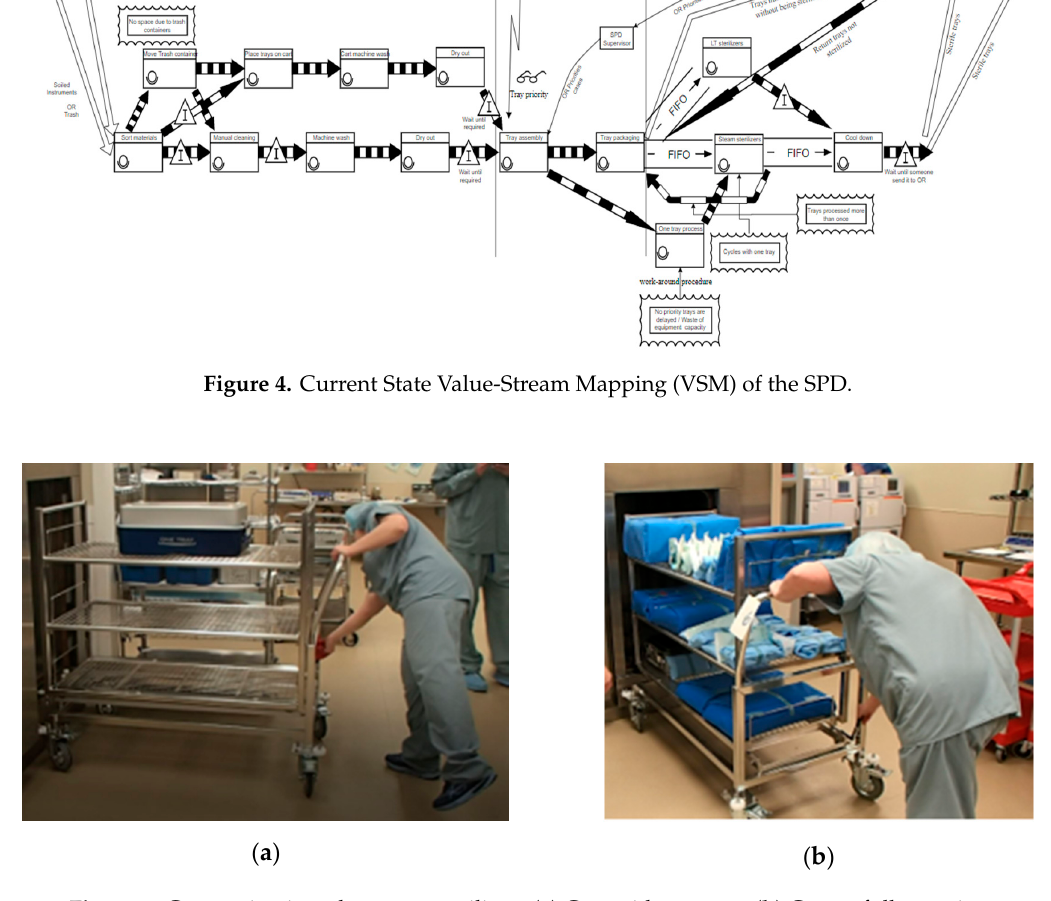
Figure 4. Current State Value-Stream Mapping (VSM) of the SPD.